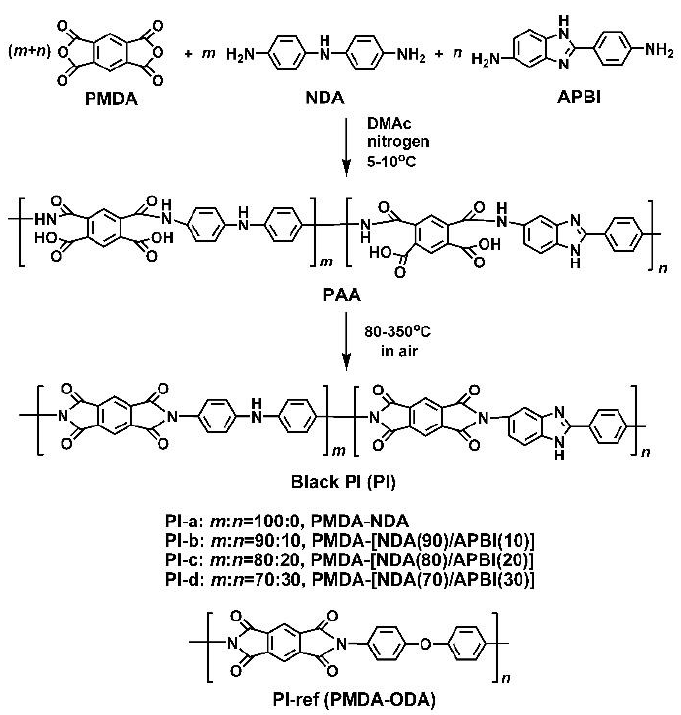
Figure 2. Synthesis of black PIs and PI-ref films.